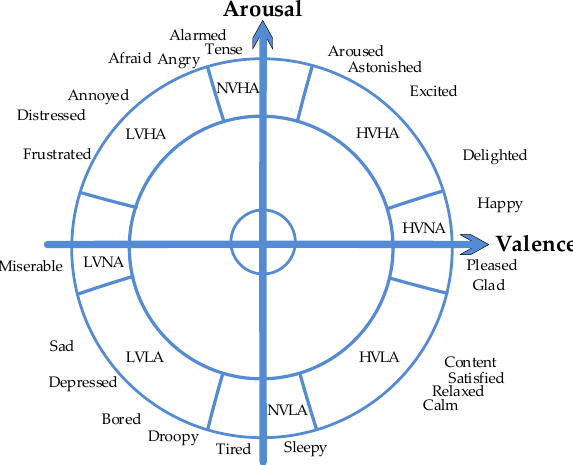
Figure 1. 2D valence-arousal emotion model by Russell.